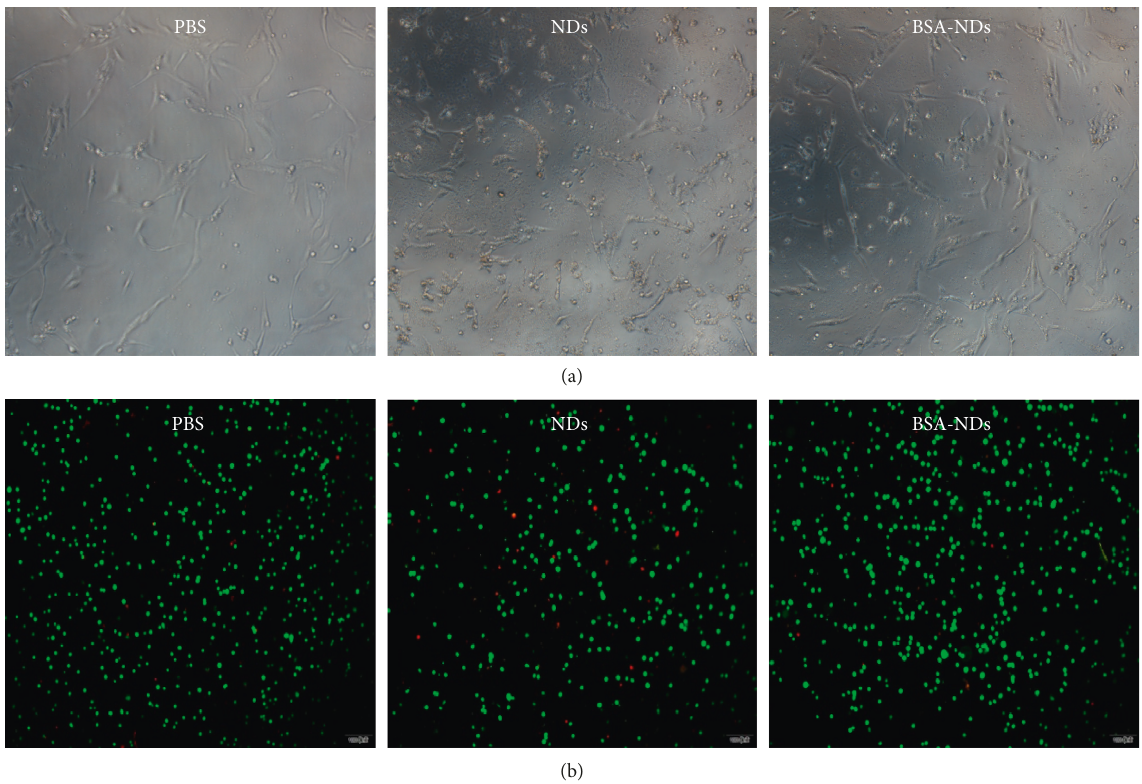
Figure 4: (a) Optical microscope images of BEAS-2B cells cultured with PBS, NDs without serum protein, and BSA-NDs. (b) Viable cells were stained green with calcein AM and dead cells were stained red with ethidium homodimer-1 ( c PBS : 0.01 M; c NDs : 8mg · L − 1 ; c BSA : 6.0 μ M).